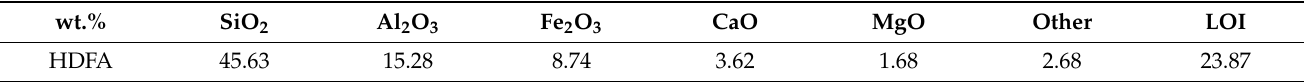
Table 1. Chemical analysis of a raw material.